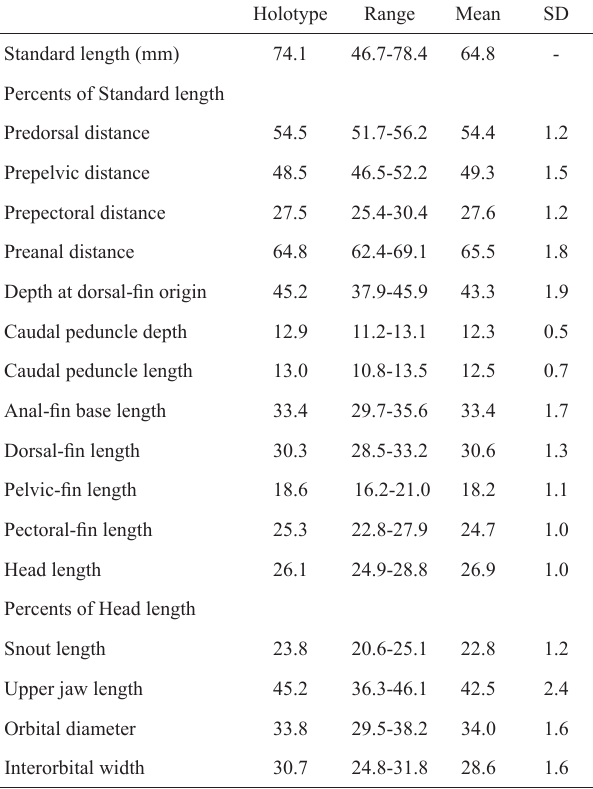
Table 1. Morphometric data for holotype and